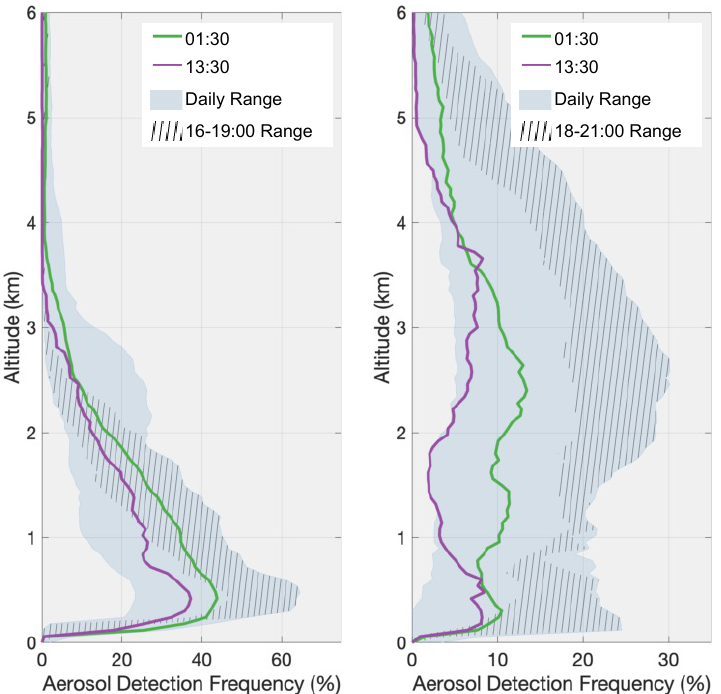
Figure 8. In 2015–2017, July, August, September, vertical aerosol detection frequencies (Aerosol CAD Score >|=5|) for the Southeast Asia region represented in Figure 6 ( left ) and for Northwestern North America (125 ◦ W–100 ◦ W; 40 ◦ N–51 ◦ N) ( right ). Blue shaded region denotes the daily range of hourly observations, black hatching for the range of observations in the peak aerosol local hours (16:00–19:00 Southeast Asia and 18:00–21:00 for Northwestern North America). Solid lines denote the hours corresponding to the A-Train crossing (green morning, purple